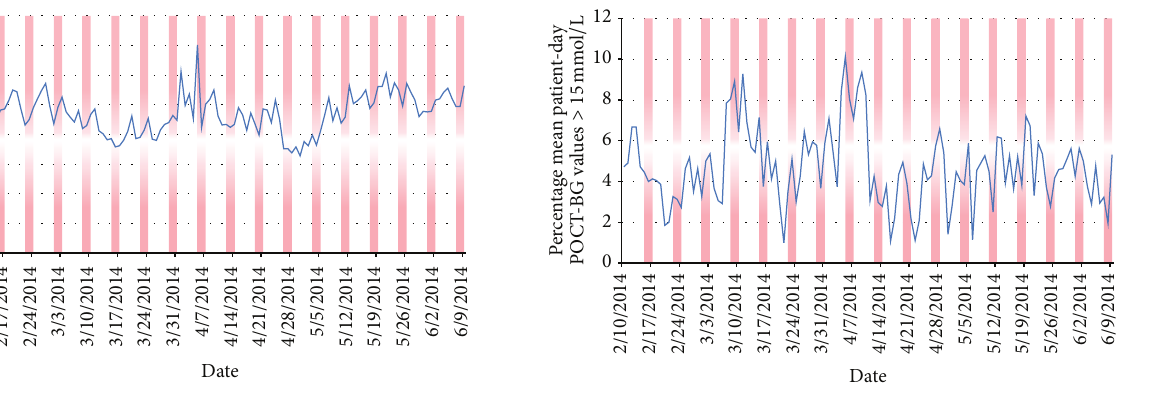
Figure 6: Line graph showing the percentage of mean patient-day weighted POC-BG results greater than 15mmol/L by date in all ward locations analysed. Red area bars represent